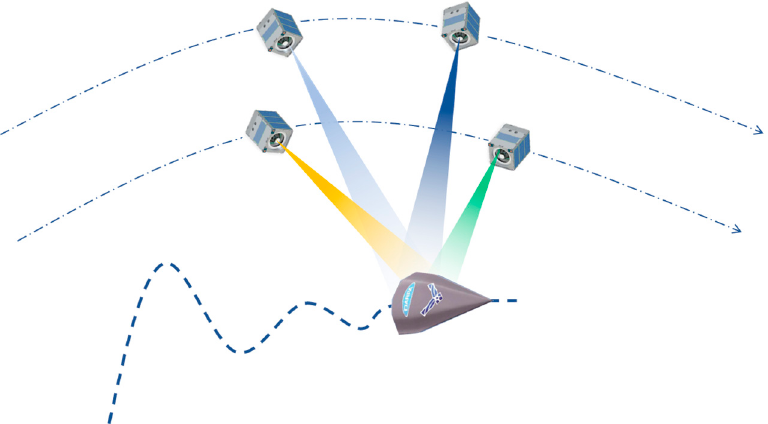
Figure 2. The schematic diagram of multiple satellites tracking the target.